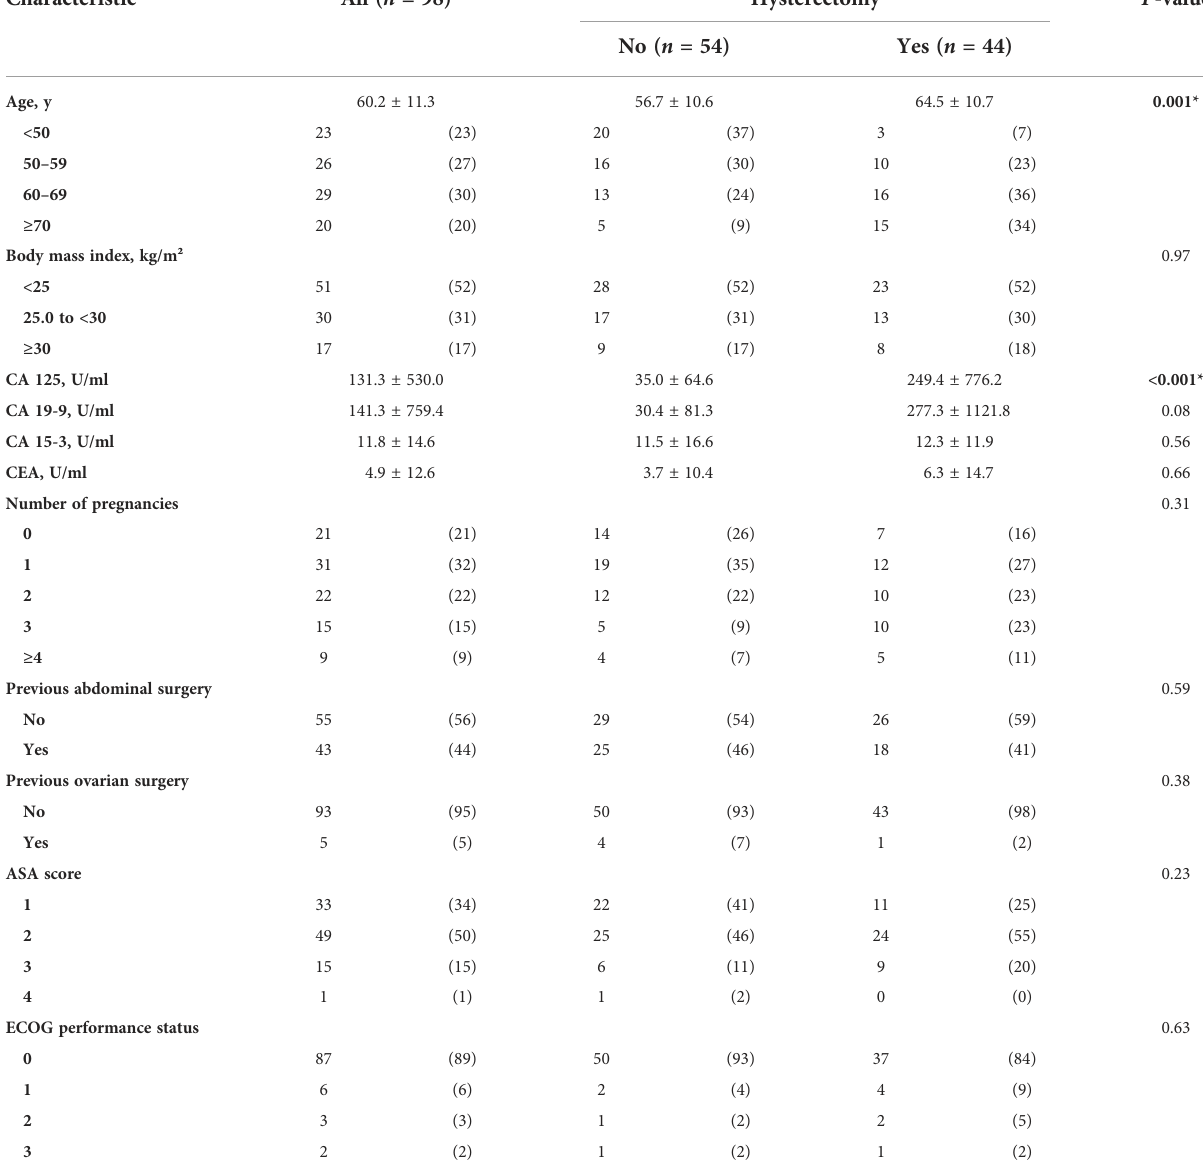
TABLE 1 Demographic and clinical data of the study population. Characteristic All ( n = 98)